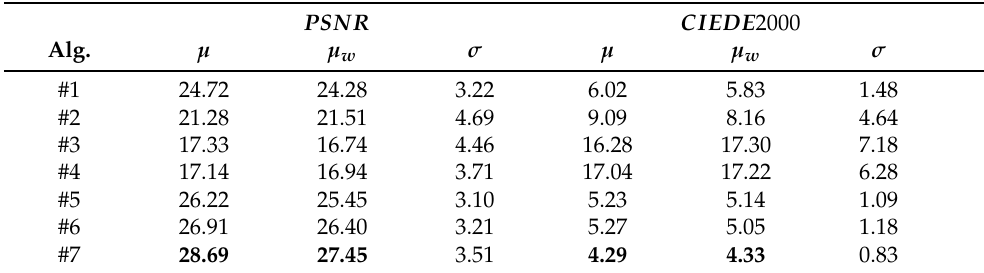
Table 2. Image-based quantitative evaluation: simple mean, weighted mean, and standard deviations of the PSNR and CIEDE 2000 scores of all images for each algorithm (rows). The best results are highlighted in